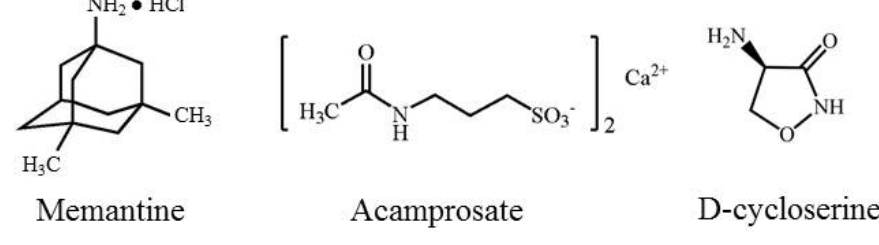
Figure 1. Chemical structures of memantine, acamprosate, and D